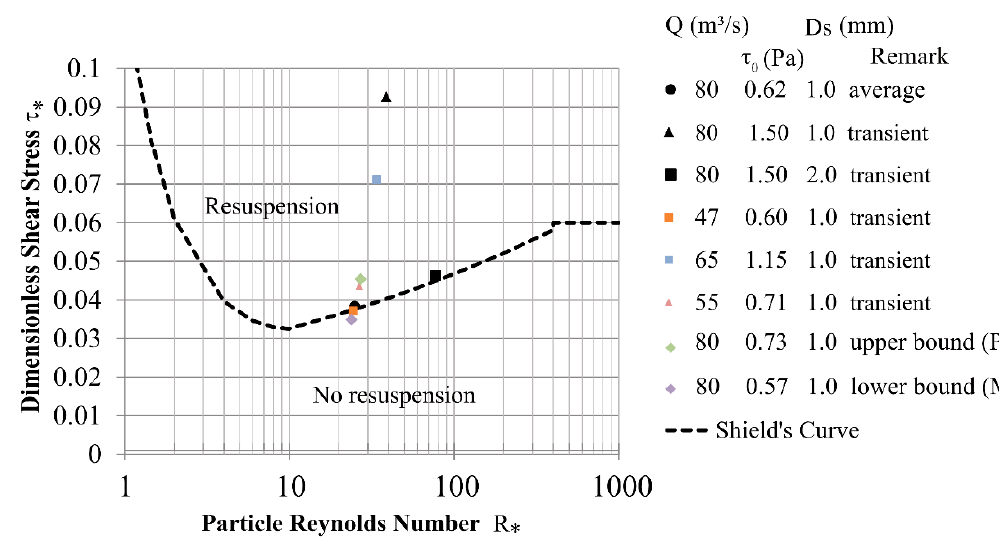
Figure 14. Shields curve with points for characteristic sediment diameters, calculations based on [32–34]. The values are given in prototype scale and the Shields curve (data from [35]).